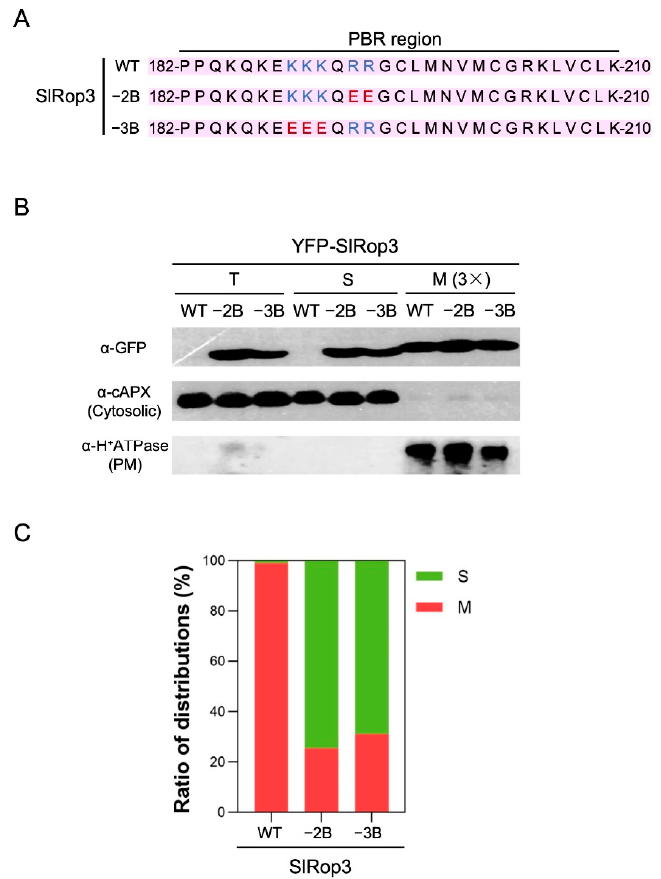
Figure 3. The correlation between the number of basic residues in the PBRs and subcellular localization. ( A ), illustration of the positions of basic amino acid substitutions in the PBR region of SlRop3. − 2B and − 3B indicate two and three basic residues were mutated to acidic glutamic acid (E), respectively. Blue and red letters represent selected basic residues without and with mutations, respectively. ( B ), Subcellular accumulation of SlRop3 mutants in N. benthamiana . YFP-fused SlRop3 wild type and mutants were overexpressed in tobacco leaves. PM: plasma membrane; T: total extract, S: soluble fraction, M: microsomal fraction. M (3×) indicates three times enrichment relative to S. Immunoblotting was performed with anti-GFP (for SlRop3), anti-H + ATPase (PM marker), and anti-cAPX (cytoplasm marker) antibodies. ( C ), Ratio of membrane and cytosolic distributions of YFP-SlRop3 mutants. Red and green bars indicate the percentage of membrane and cytosolic fractions, respectively. S: soluble fraction, M: microsomal fraction. The experiment was repeated twice.